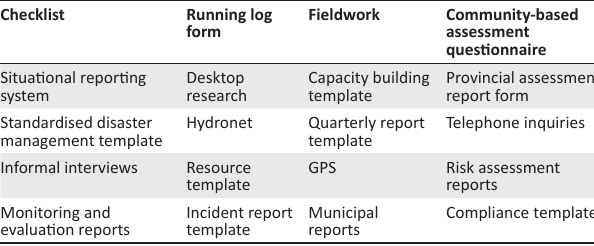
TABLE 1: Data collection methods.